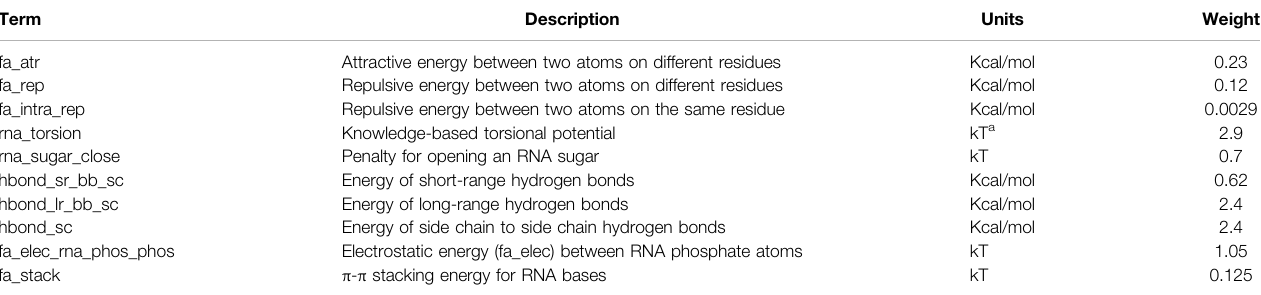
TABLE 2 | Parameters of energy function ( rna_loop_hires_04092010 ). Term Description